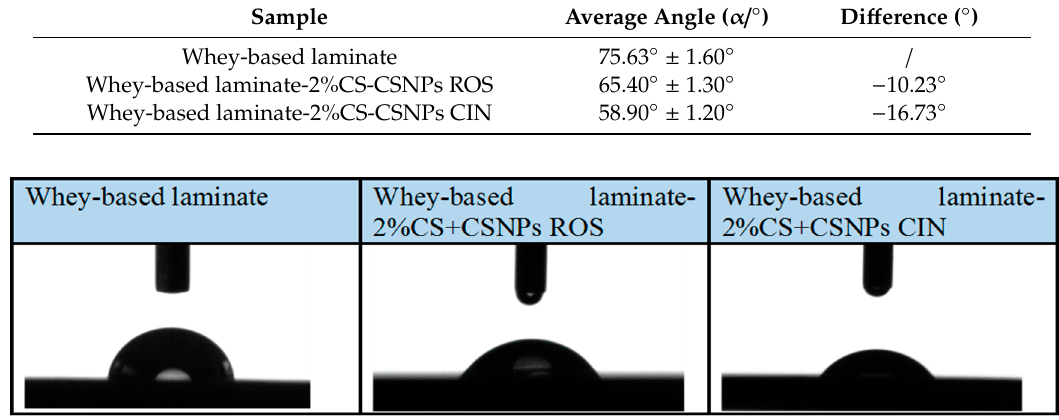
Figure 4. Static contact angle measurements of whey-based laminates.